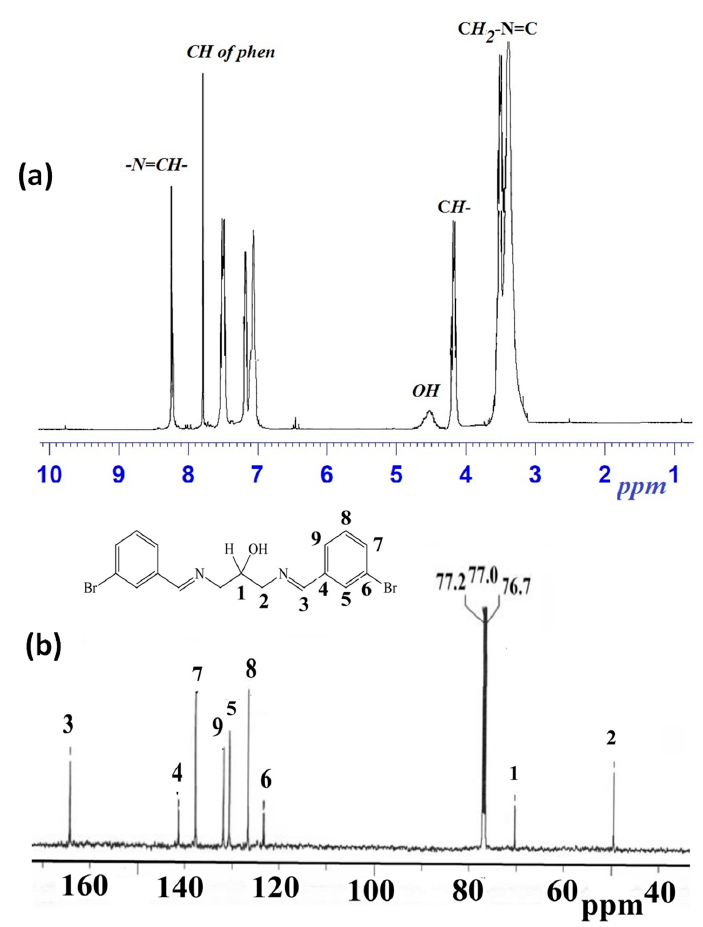
Figure 4. ( a ) 250 MHz 1 H-NMR and ( b ) 62.5 MHz 13 C-NMR of 1,3-bis[( E )-(3-bromobenzylidene)amino]propan-2-ol in CDCl 3 .